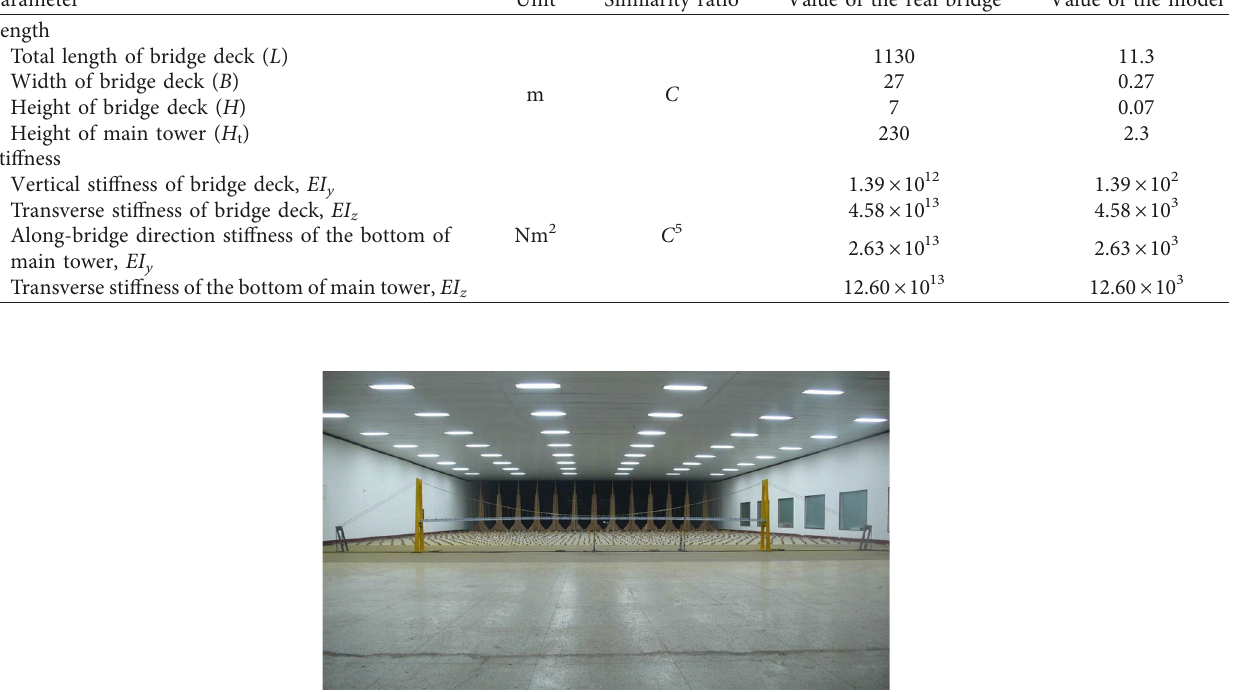
Figure 9: Test model of the suspension bridge. Table 7: Comparison of vibration